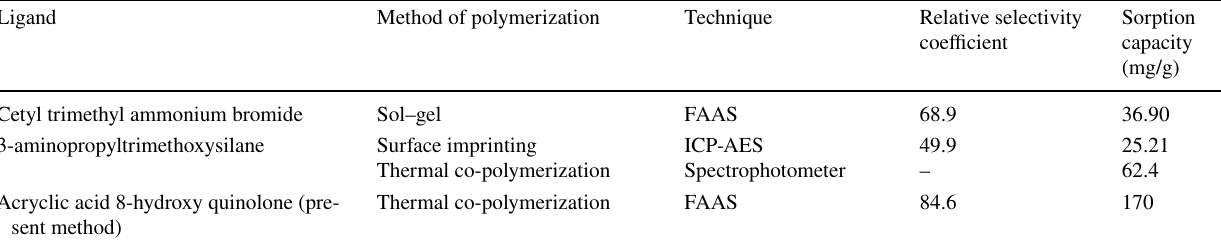
Table 1 Comparison of the sorbent characteristic of various Fe(III)-imprinted polymer with present study